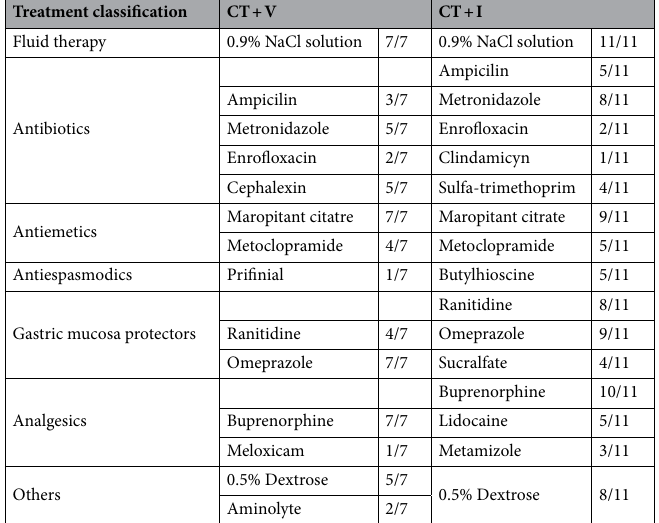
Table 2. Conventional treatment in CT + V and CT + I groups. Treatments were classified according to their action mechanism. The number of puppies that received each of the treatments is specified. CT conventional treatment, I immunomodulatory, V